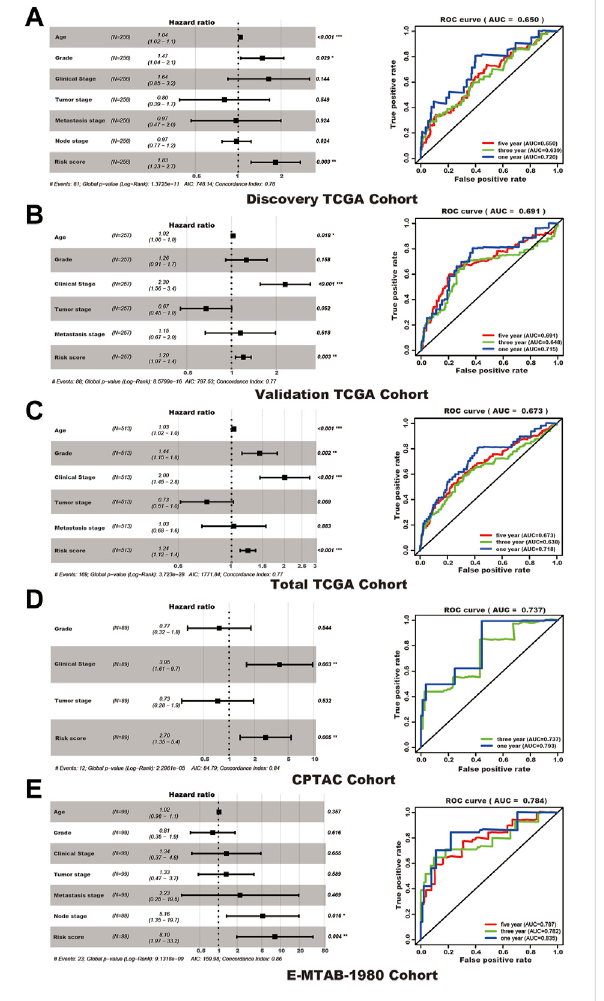
intensity below the 25th percentile), moderate expression (staining intensity between the 50th and 75th percentiles), and high expression (staining intensity above the 75th percentile).